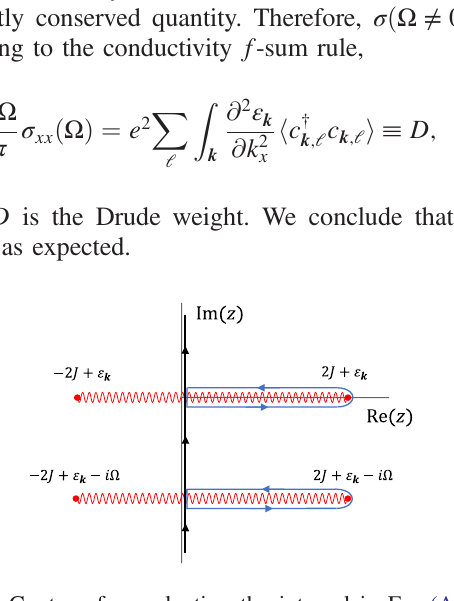
FIG. 9. Contour for evaluating the integral in Eq. (A6). The original integral is along the contour z ¼ i ω . The contour can be deformed into the two closed contours shown in blue, going around the branch cuts of the